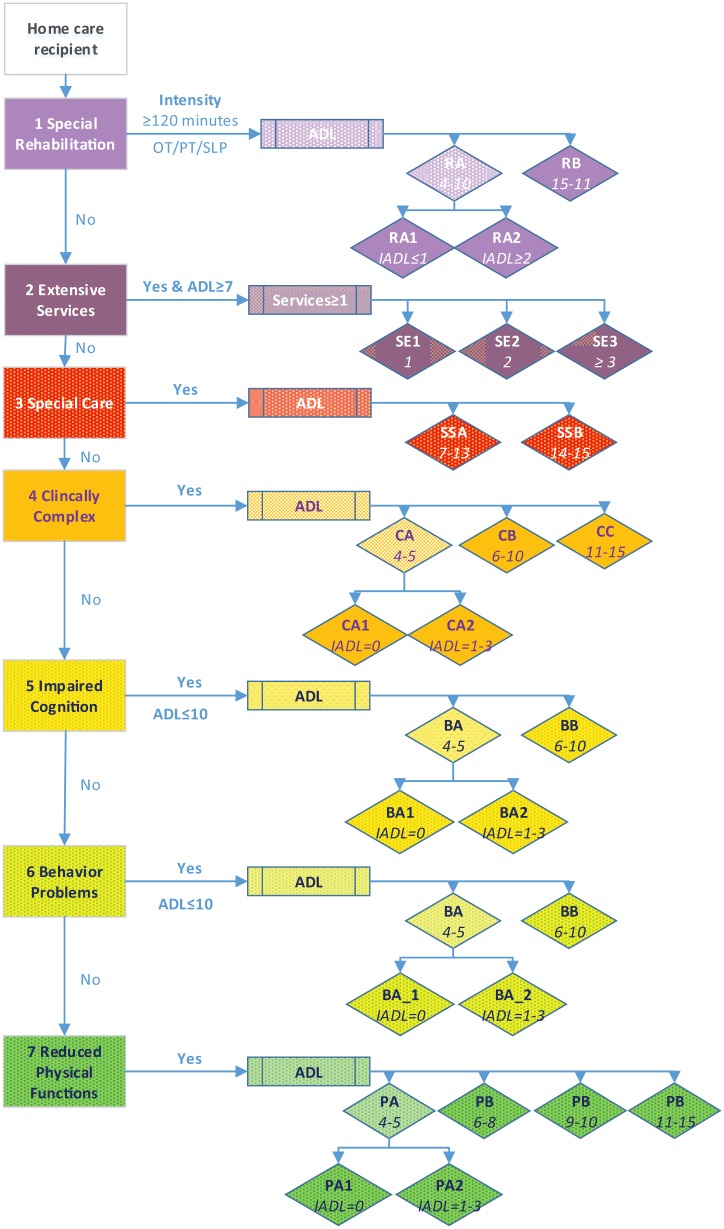
Algorithm Resources Utilization Groups of home care recipients (reproduced from Poss et al.19).